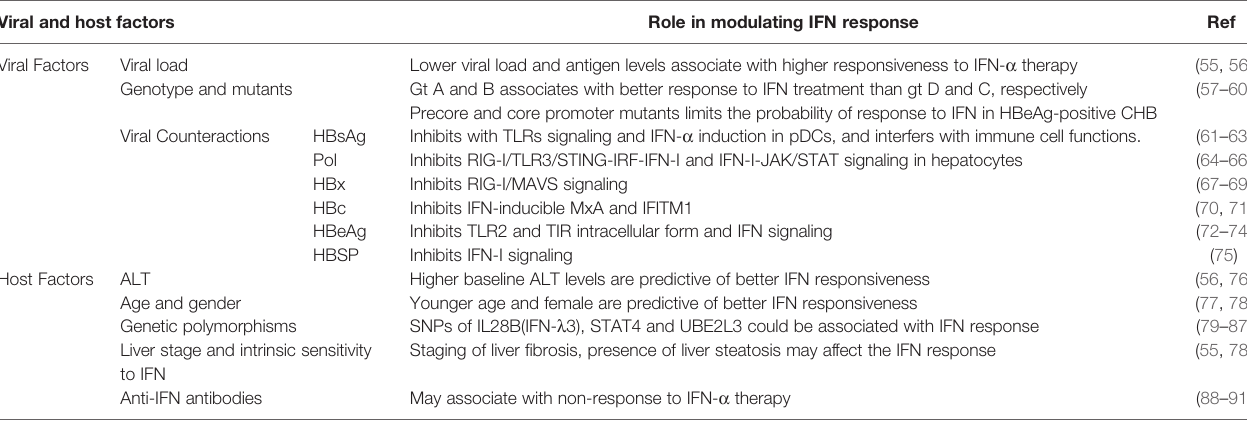
TABLE 1 | Viral and host factors that affect IFN response during HBV infection and IFN